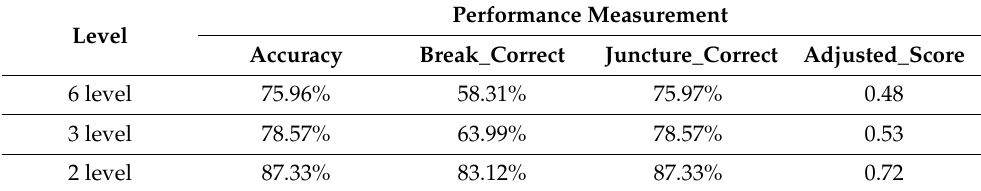
Table 11. Overall performance of suggested